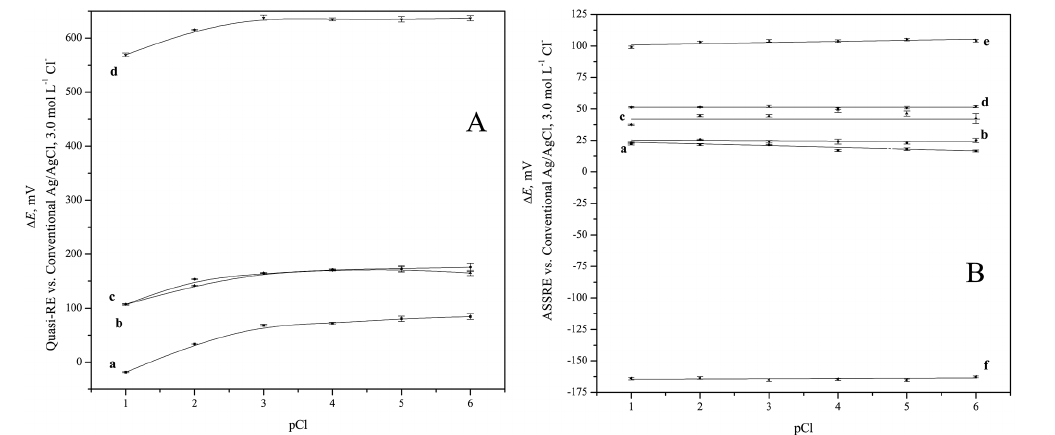
Figure 1. Potential measured with the quasi-reference electrodes (Quasi-RE) or all-solid-state reference electrodes (ASSREs) against a conventional reference electrode at room temperature. Curves obtained with (A) quasi-RE with an amount of C graphite /Ag/AgCl particles in the paste equal to (a) 15% w/w , (b) 30% w/w , (c) 45% w/w , and (d) BQ164 ink from Dupont; and (B) ASSREs containing the salts (a)